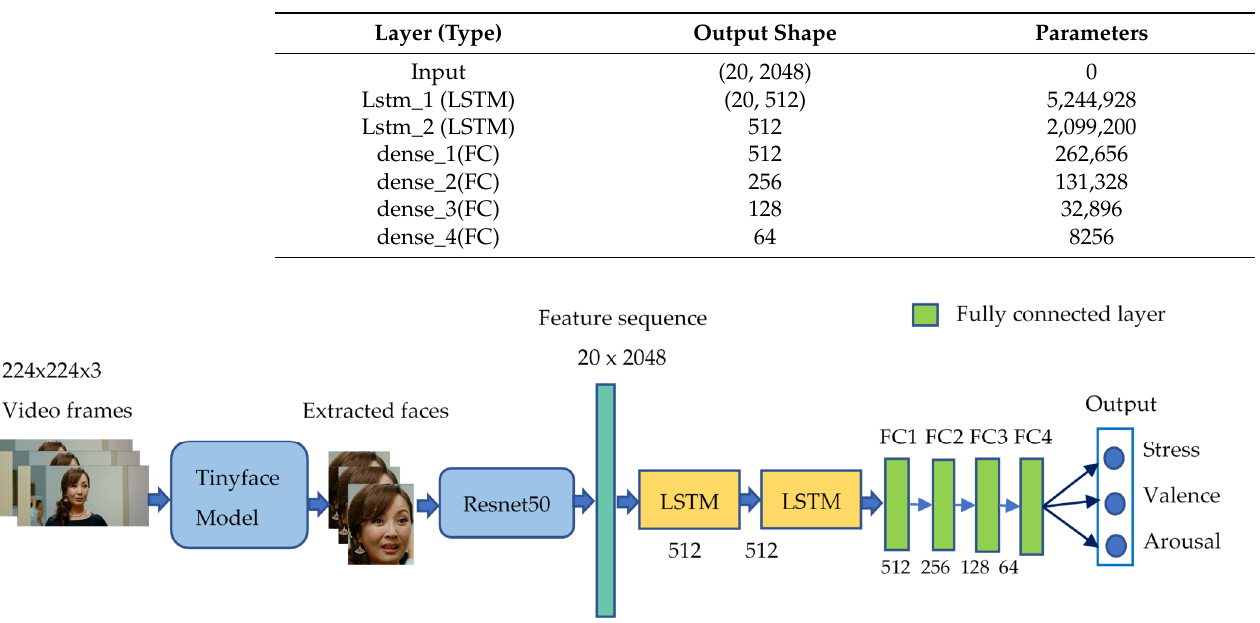
Table 6. Network parameters.